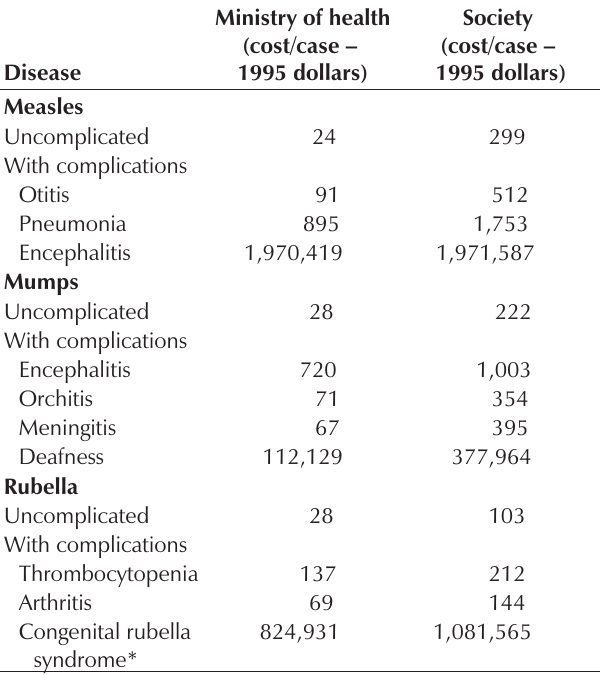
Estimated lifetime costs from a societal perspective of the most expensive complications from measles, mumps and rubella